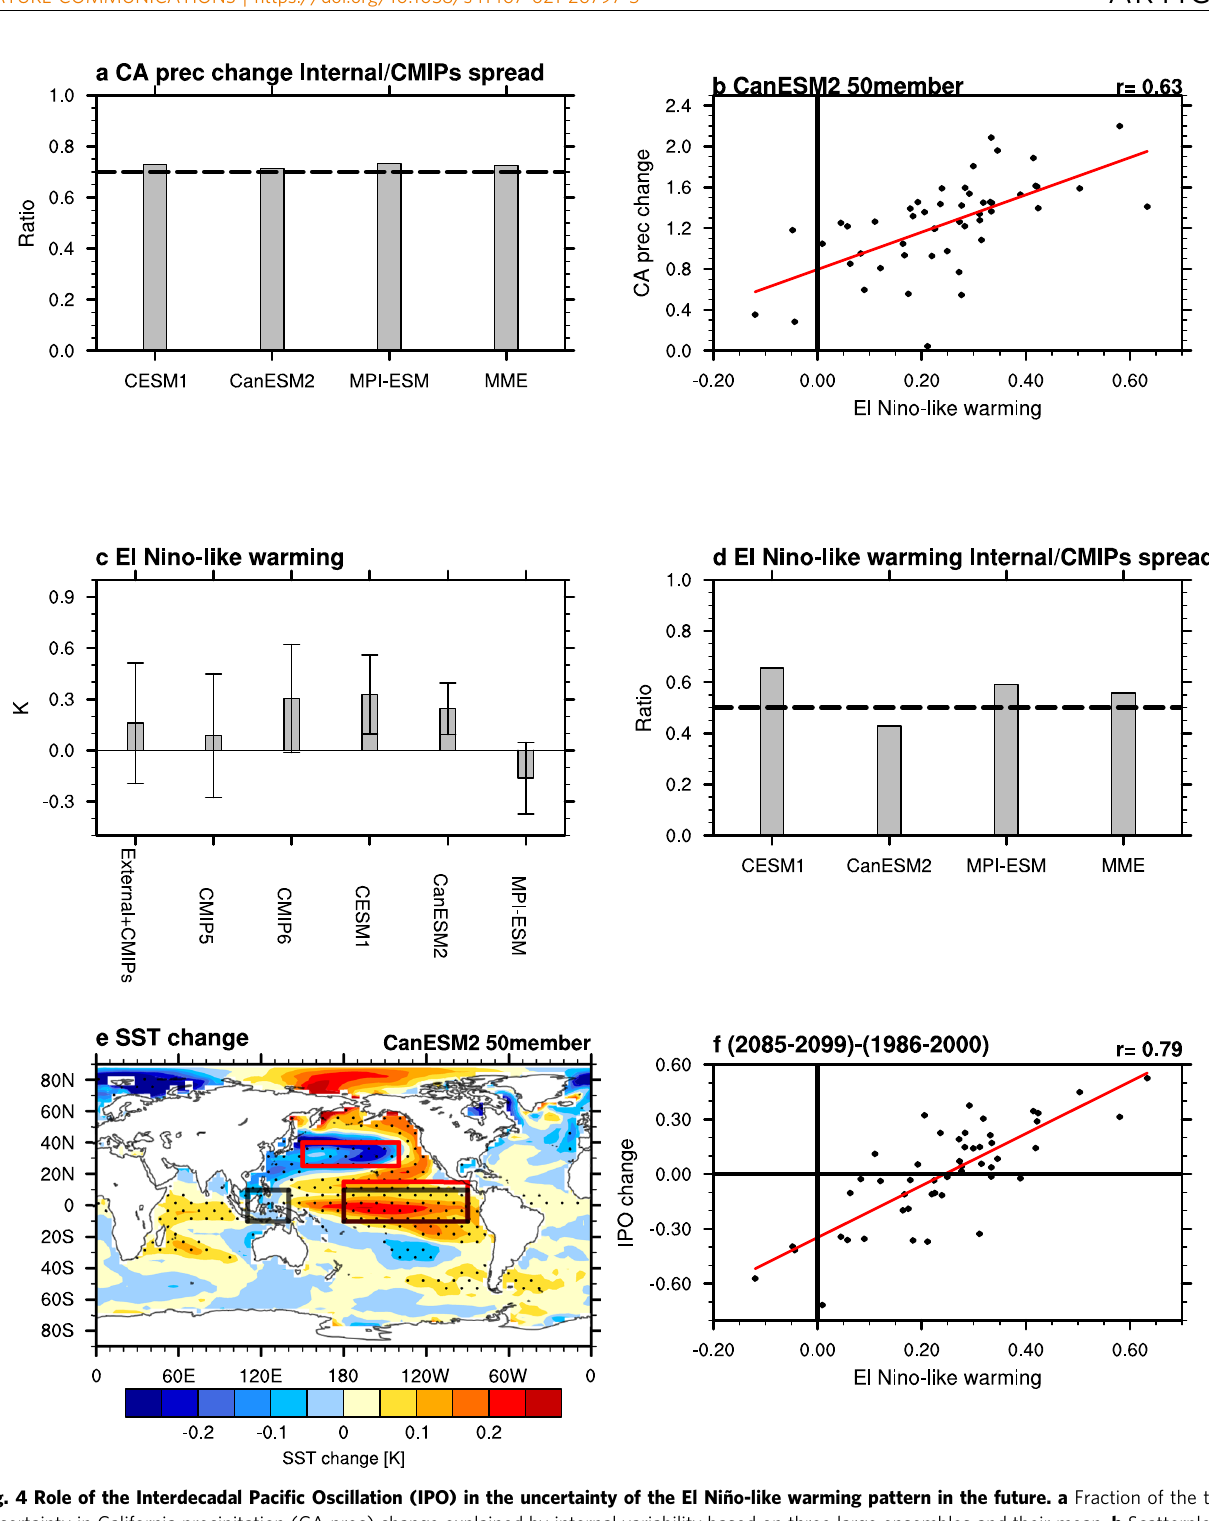
Fig. 4 Role of the Interdecadal Paci fi c Oscillation (IPO) in the uncertainty of the El Niño-like warming pattern in the future. a Fraction of the total uncertainty in California precipitation (CA prec) change explained by internal variability based on three large ensembles and their mean. b Scatterplots of the El Niño-like warming (K, x -axis) versus California precipitation change (mm day − 1 , y -axis) based on 50 members from CanESM2. c The El Niño-like warming pattern change (K) based on all members, 57 CMIP5 members, 71 CMIP6 members, 40 CESM1, 50 CanESM2 and 100 MPI-ESM, respectively. Grey bars denote the ensemble mean, and error bars denote one standard deviation. The fi rst term denotes the effect of external forcing (average of fi ve large ensembles, grey bar) and the total uncertainty of 128 CMIP5 and CMIP6 simulations (error bar). d Fraction of the total uncertainty in El Niño-like warming explained by internal variability based on three large ensembles and their mean. e Intermember regressions of sea surface temperature (SST) change (K) onto the El Niño-like pattern change based on 50 members from CanESM2. f Scatterplots of the El Niño-like warming (K, x -axis) versus the IPO change (K, y -axis) based on 50 members from CanESM2. The regression line is shown as the red line and the intermember correlation (r) is shown at the top-right of panel b and f . The El Niño-like pattern is based on the SST inside the black rectangles, and the IPO is based on the SST inside the red rectangles in e . All the changes are based on the difference between RCP8.5/SSP585 (2085 – 2099) and historical (1986 – 2000). NATURE COMMUNICATIONS| (2021) 12:6484